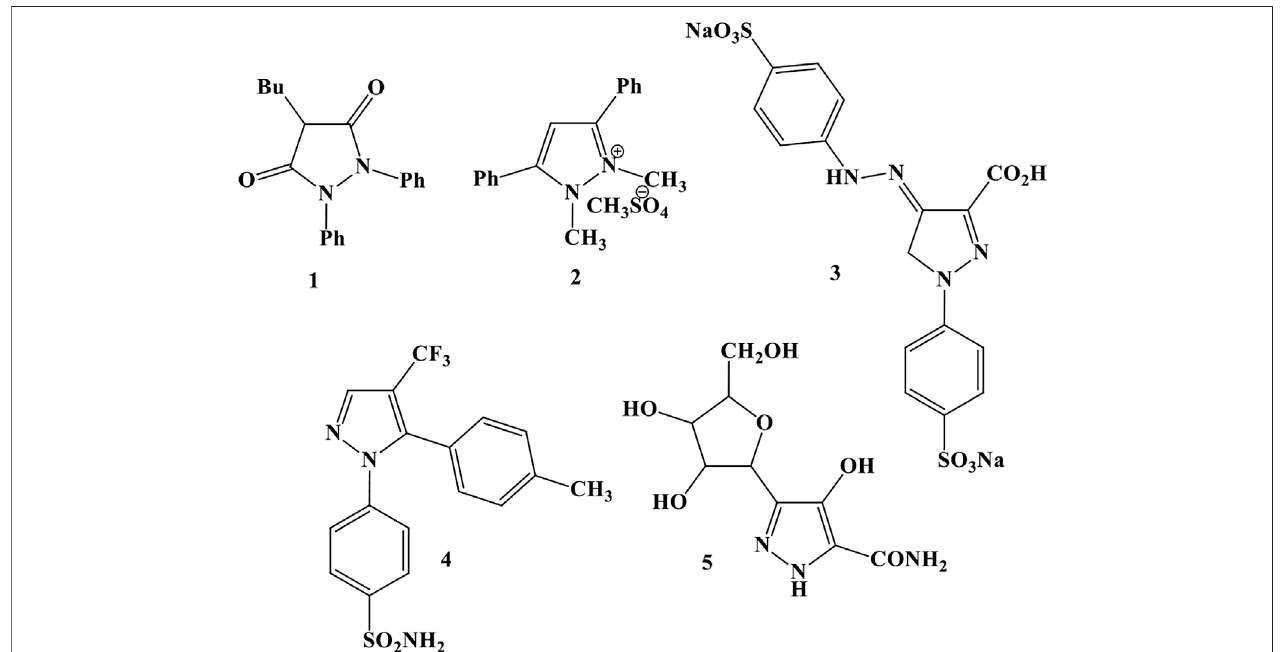
FIGURE 1 | Some of the pyrazoles having biological